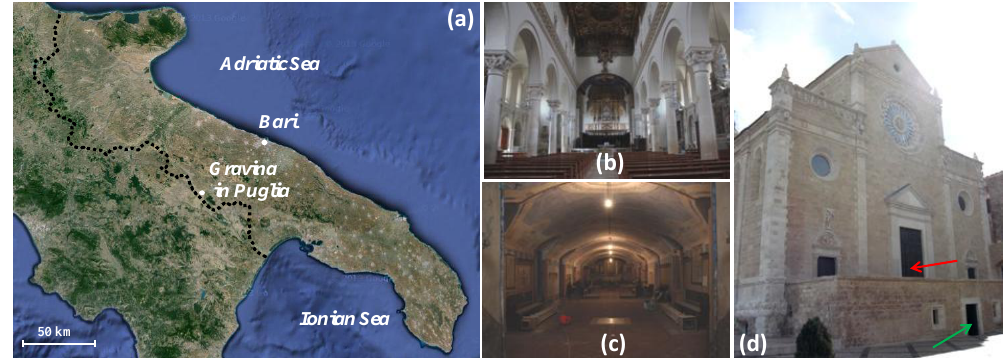
Figure 1. (a) Geographical location of Gravina in Puglia, (b) The central nave of the cathedral, (c) The central nave of the Church of Santa Croce, (d) The external façade of the building with the entrance of the cathedral (upper red arrow) and of the Church of Santa Croce (lower green